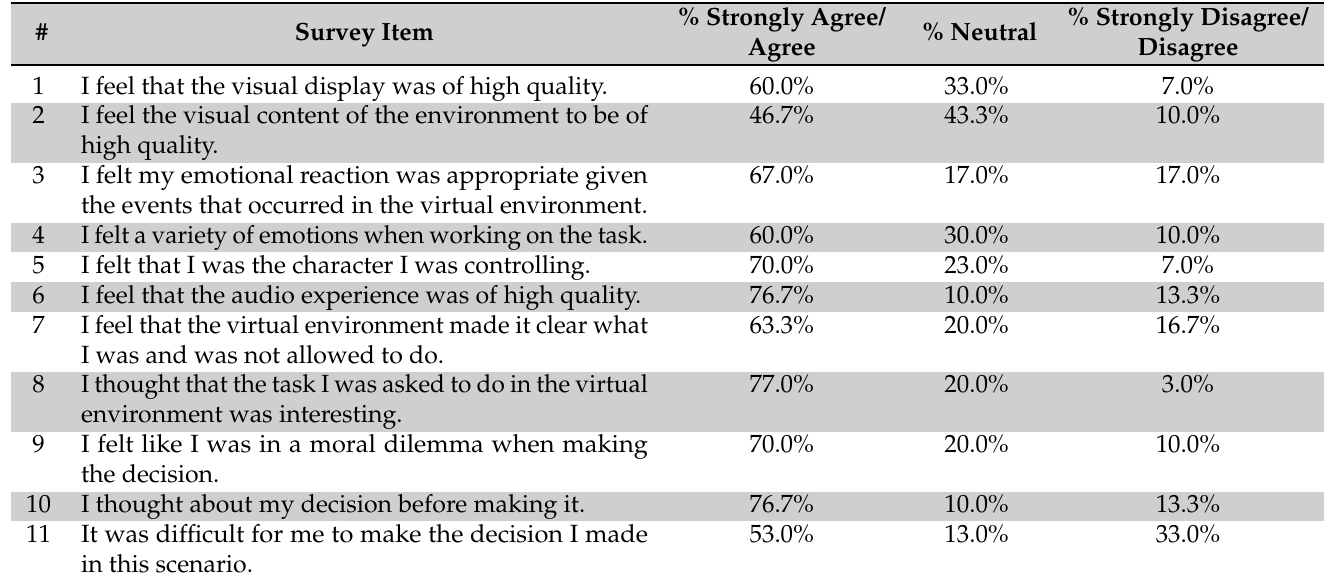
Table 2. Results of the post-experience survey ( n =